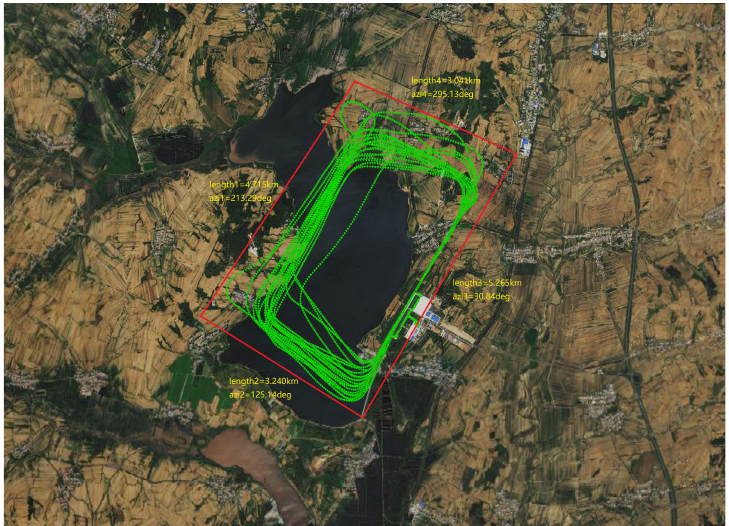
Figure 9. Flight trajectory of test-I. The green line is the trajectory, while the flight distance and azimuth are marked by the red line and the yellow